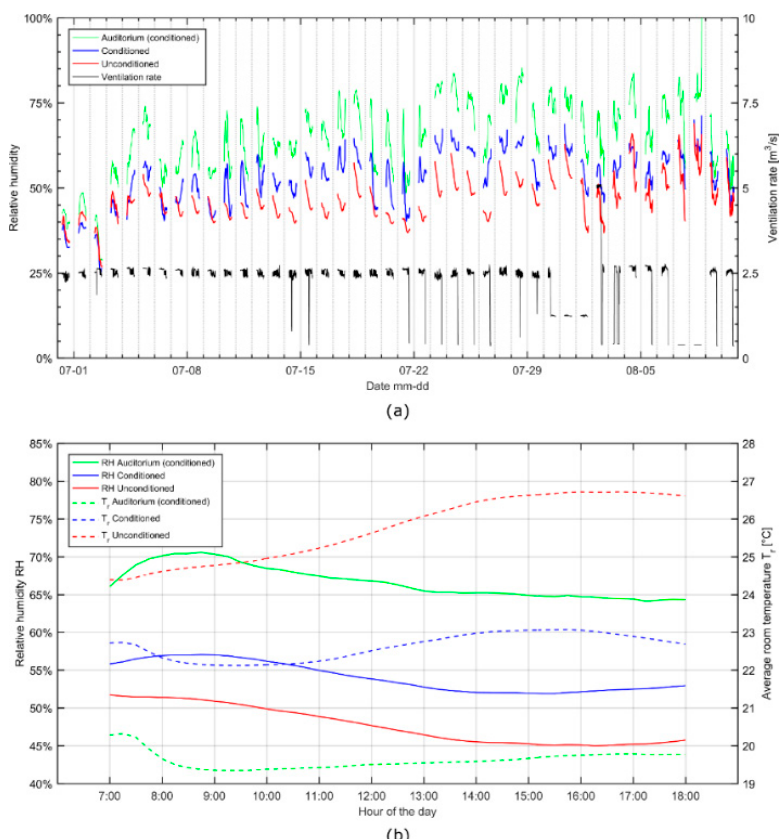
Figure 6. ( a ) Ventilation rate and relative humidity in unconditioned and conditioned rooms, respectively. Vertical grid lines mark days for clarity. ( b ) Average, variation in relative humidity (RH) and room temperature (T r ) during the hours of the day (i.e., the sum of all daily responses normalized by the number of days summed).